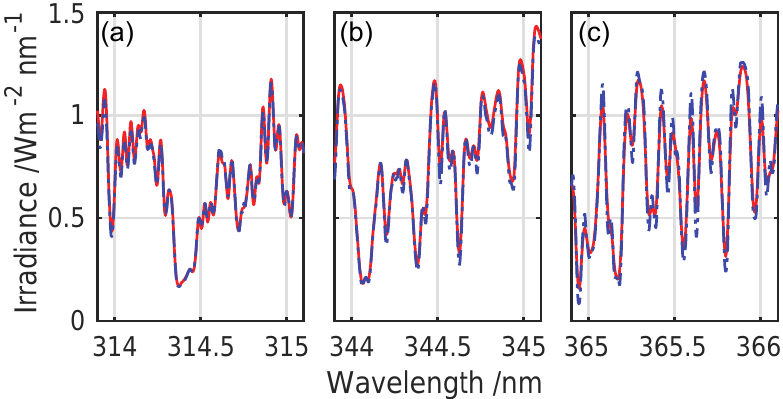
Figure 4. FTS (red curve) and COKITHQA (Kitt Peak; dashed blue curve) solar spectra for three spectral intervals. Panel (a) shows the two solar spectra from 313.9 to 315.1nm, panel (b) from 343.9 to 345.1nm and panel (c) from 364.9 to 366.1nm.